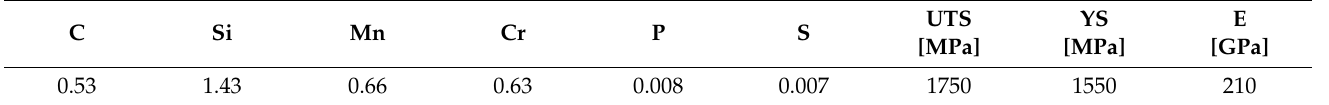
Table 1. Chemical composition and mechanical properties of SAE 9254 (mass fraction in percent).